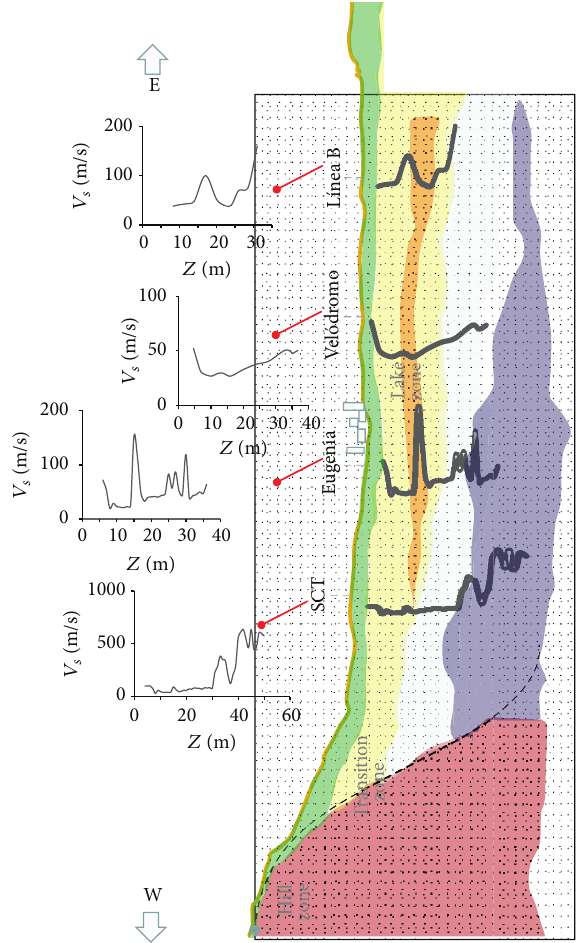
Figure 9: Layer definition using “virtual” profiles (every vertical dotted line is a “virtual” axis boring) and “real” exploration